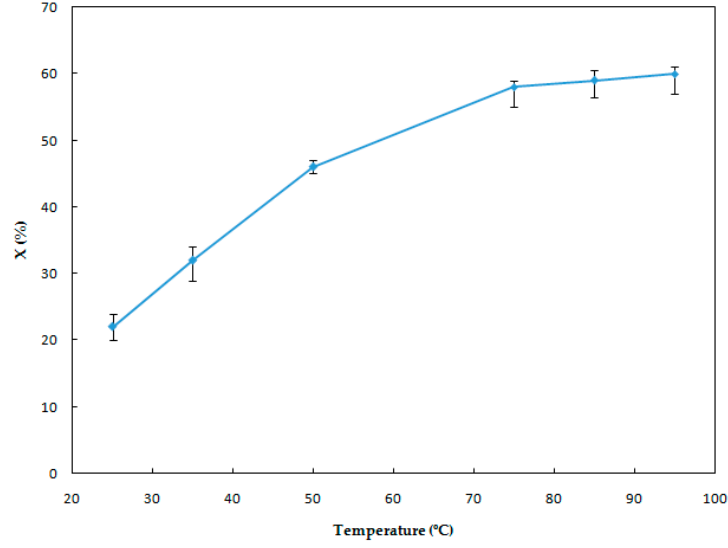
Figure 2. Effect of temperature on the dissolution of LiCoO 2 .